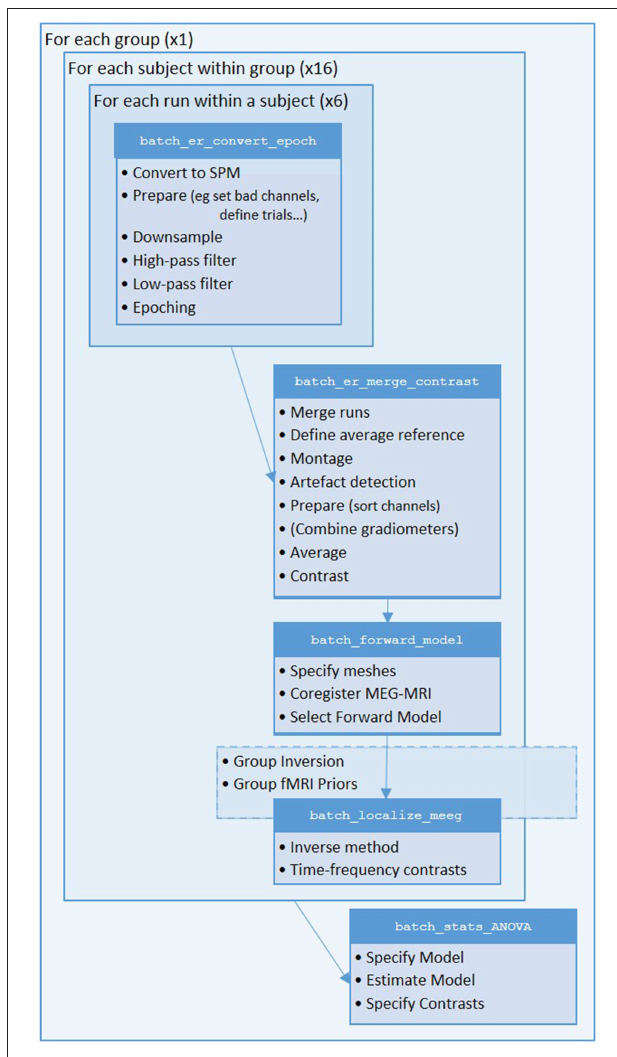
FIGURE 2 | Full pipeline. The MATLAB filenames at the top of each box refer to the batch files (in the “manual” directory) used for each